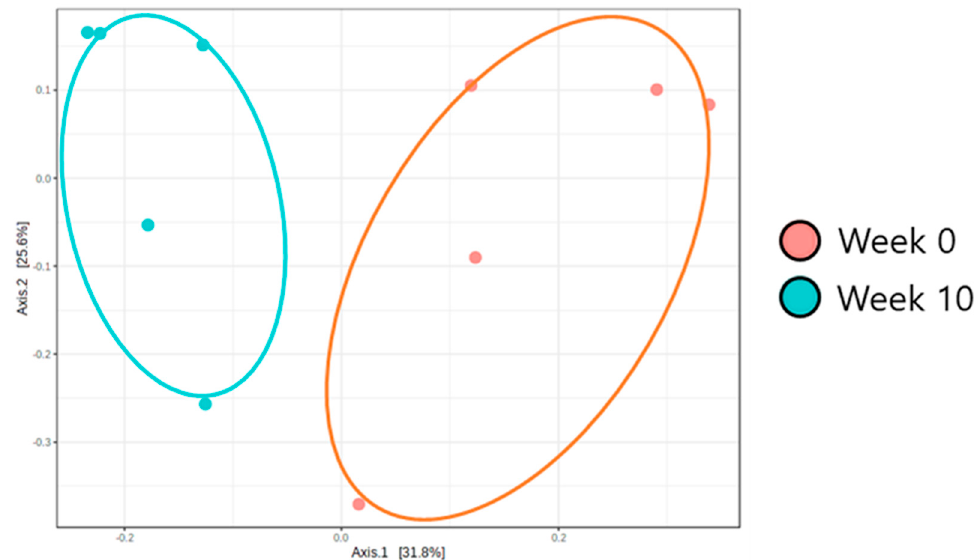
Figure 1. L. gasseri BNR17 intestinal microbiome beta diversity analysis according to synbiotic prep-aration containing L. gasseri BNR17 supplementation (PCoA: Principle Coordinates Analysis, un-weighted UniFrac Distance) (R: 0.552, p < 0.01).